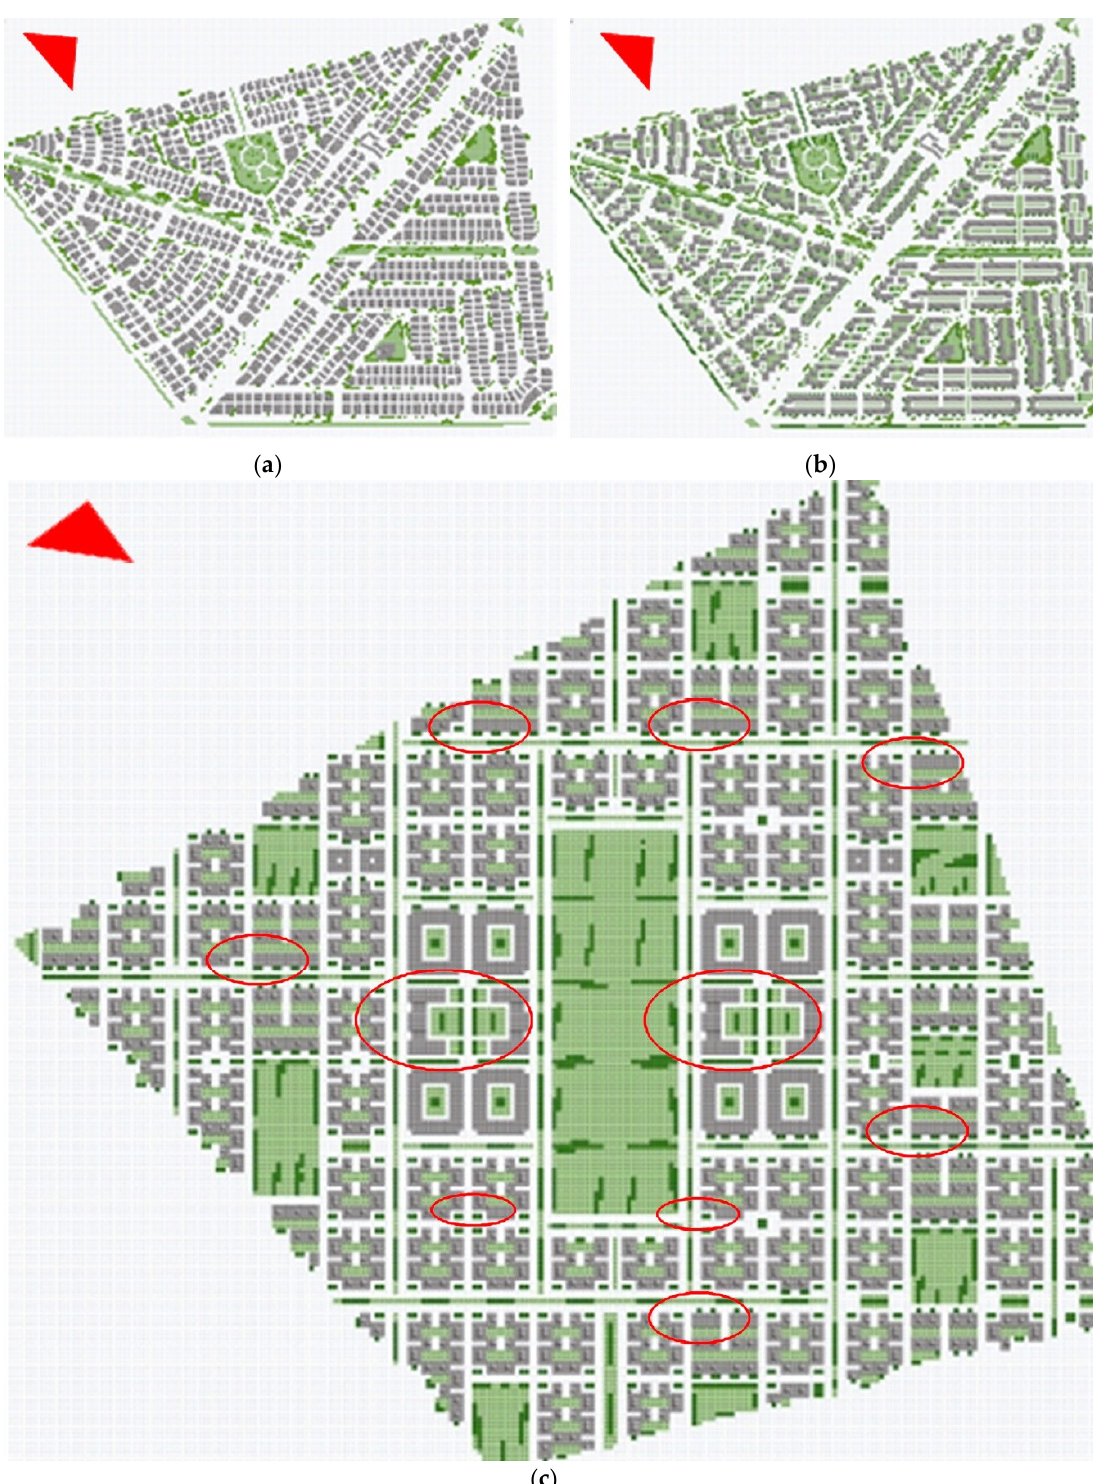
Figure 9. Master plans of ( a ) BC2, ( b ) C2DS1, and ( c ) C2DS2; buildings in grey, grass in light green, and trees in dark green. The red ellipses indicate the location of the high buildings used to help UCL wind mixing.